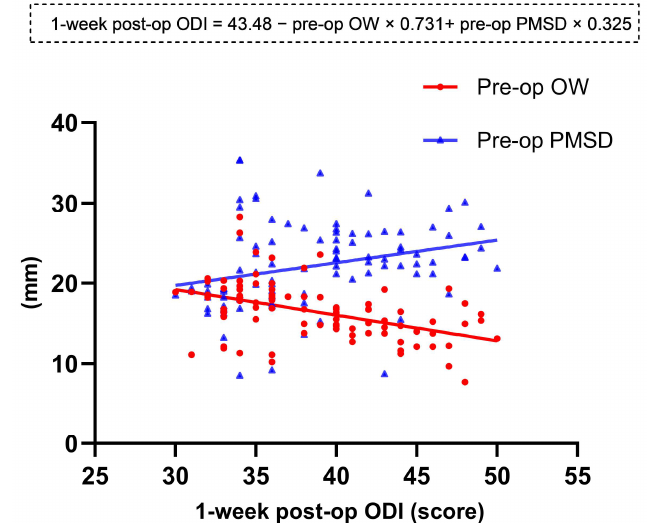
Figure 3. The multiple-regression linear model. The preoperative OW and PMSD showed significant linear correlations with the 1-week postoperative ODI.